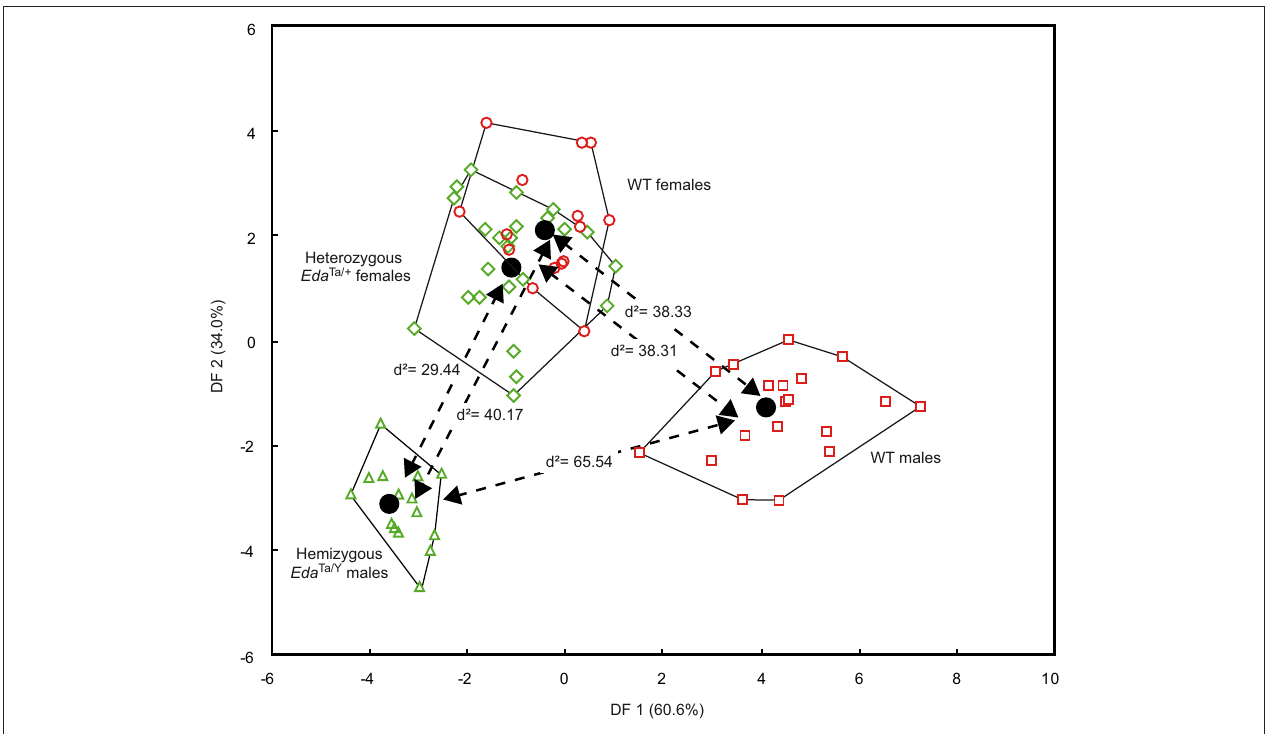
Figure 4 | results of the discriminant analysis of the mandibular elliptical Fourier descriptors. Scatterplots of the Wild-type (males: red squares; females: red circles), hemizygous Eda Ta/Y (green triangles), and heterozygous Eda Ta/ +